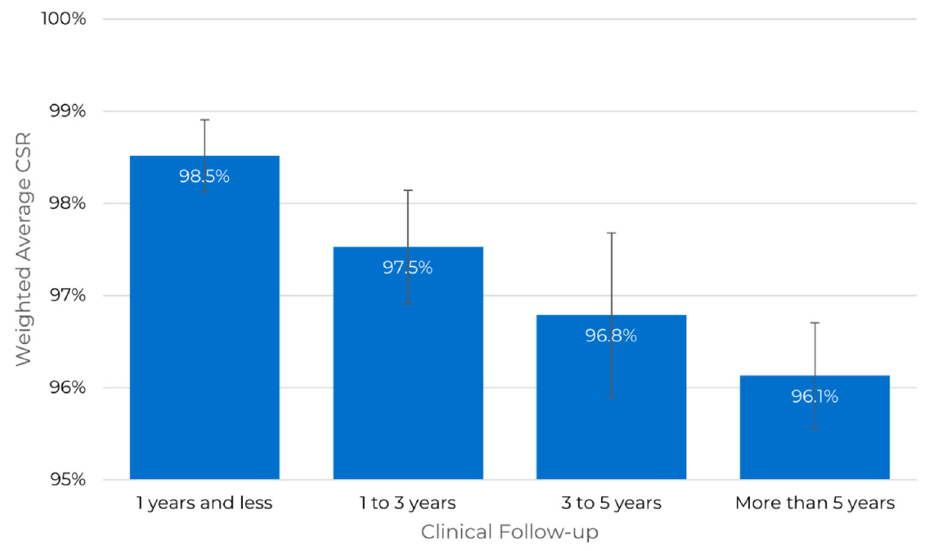
Figure 5. Average CSR (weighted mean using the patient count) as a function of clinical follow-up. The error bar represents the standard deviation of the weighted mean to account for each group’s different number of